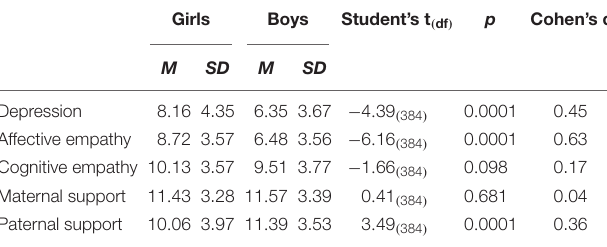
TABLE 2 | Gender differences in study variables.